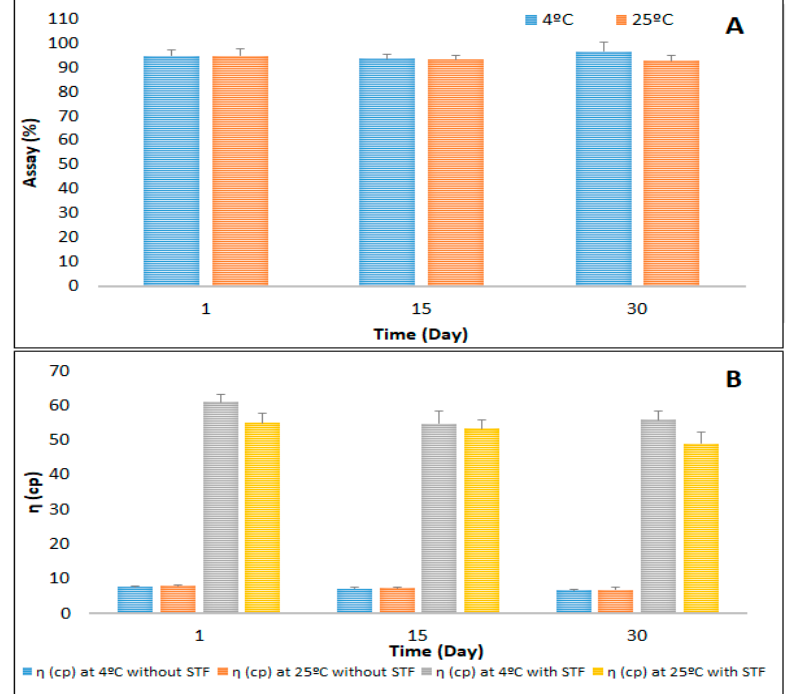
Figure 2. Stability of optimized CIP-NLC-IG formulation stored at 4 ± 2 °C and 25 ± 2 °C over one month—( A ) drug content and ( B ) viscosity (mean ± SD, n = 3).